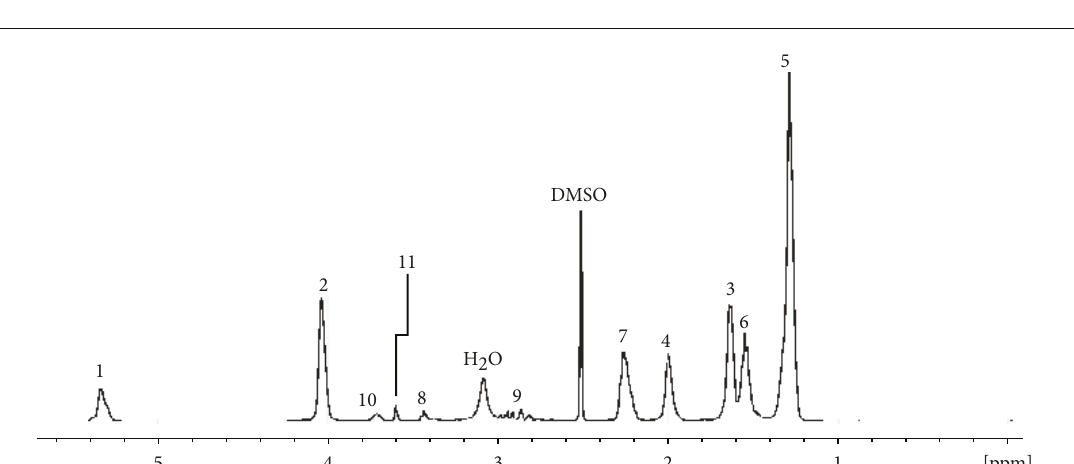
Figure 5: 1 H NMR characterization of PBC18